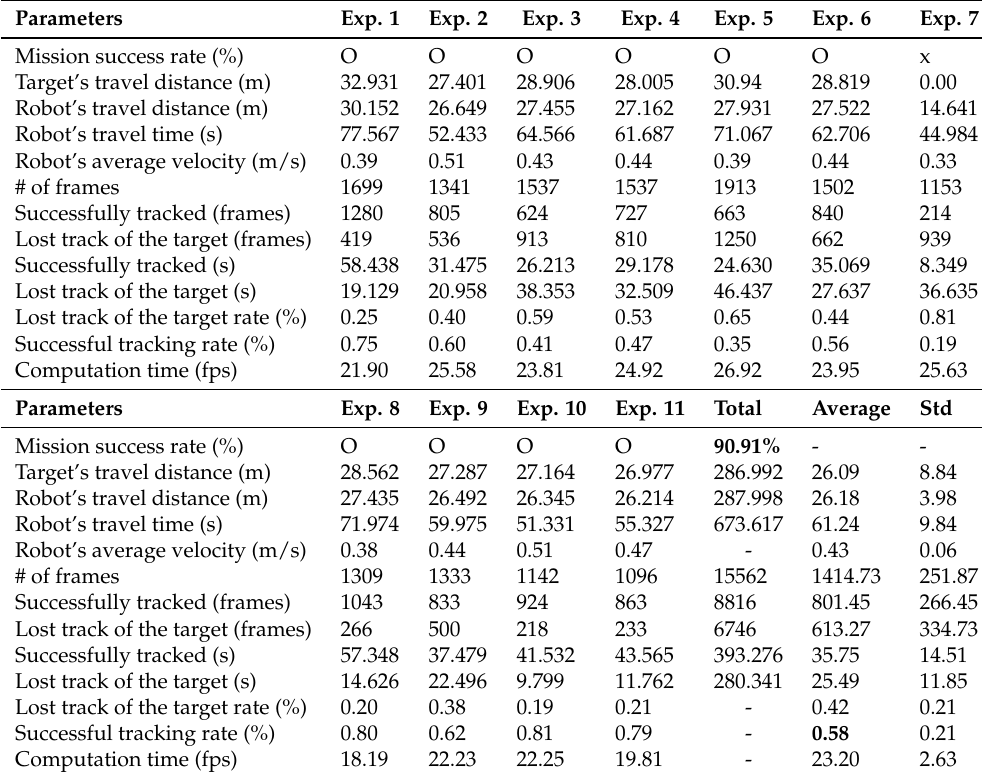
Table 2. Overall experimental results without other